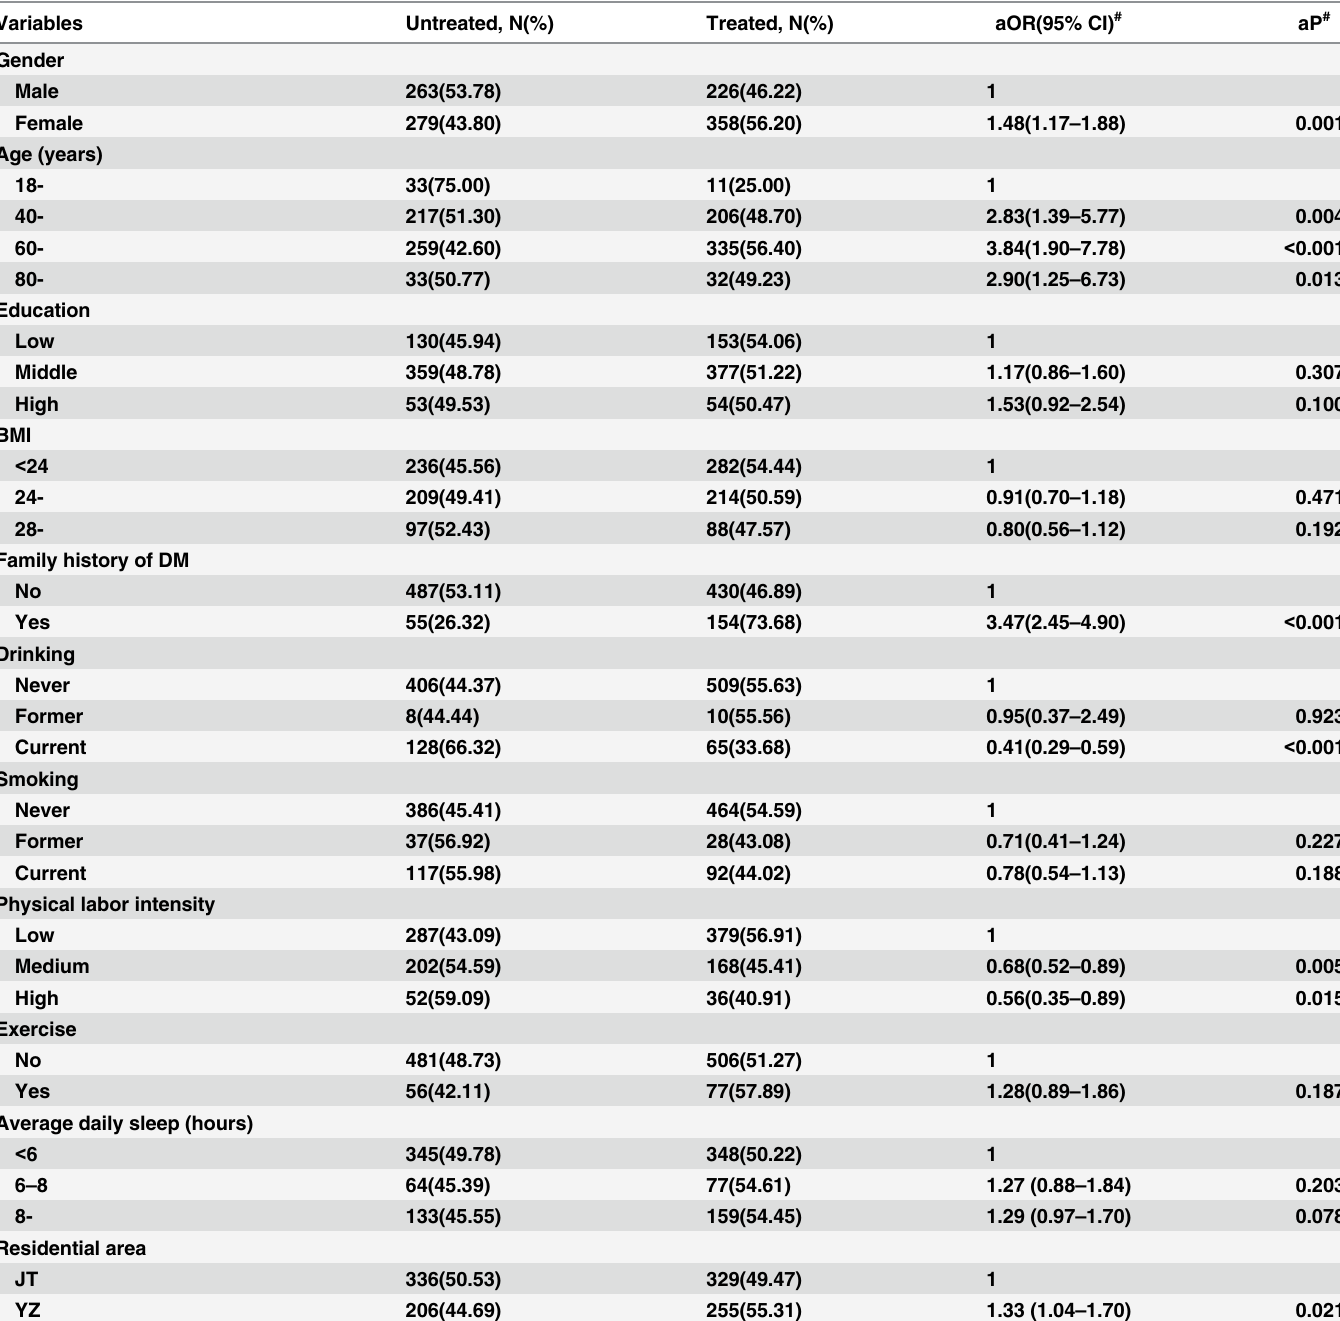
Table 5. Factors associated with diabetes mellitus